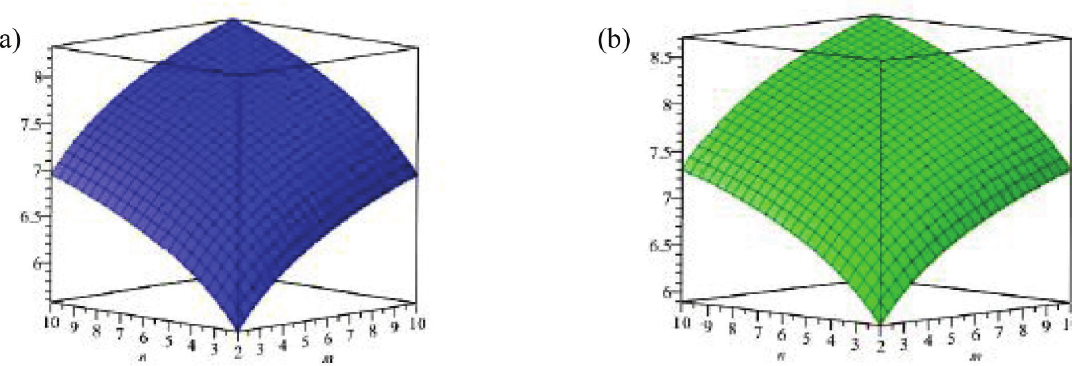
Figure 8: (a) The first Zagreb entropy, (b) the second Zagreb entropy.